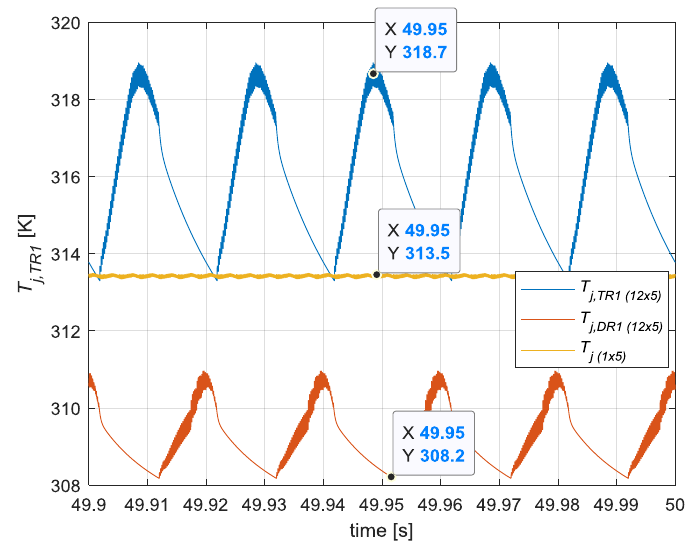
Figure 28. Zoom of the evolution of T R1 and D R1 semiconductors junction temperature obtained with individual 5-stage 12 × 5 thermal model and equivalent T j temperature obtained with the global equivalent 1 × 5 RC thermal model.